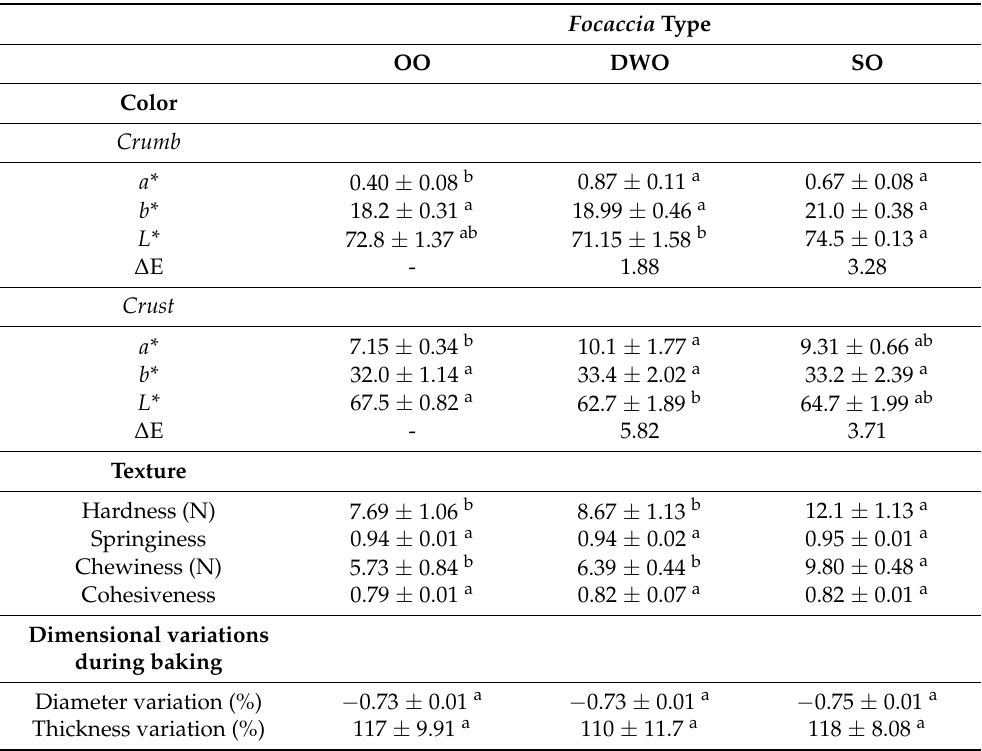
Table 6. Physical determinations (color, texture, and dimensional variations during baking) of the experimental focaccia samples. OO = focaccia prepared with olive oil; DWO = focaccia prepared with durum wheat oil; SO = focaccia prepared with sunflower oil.